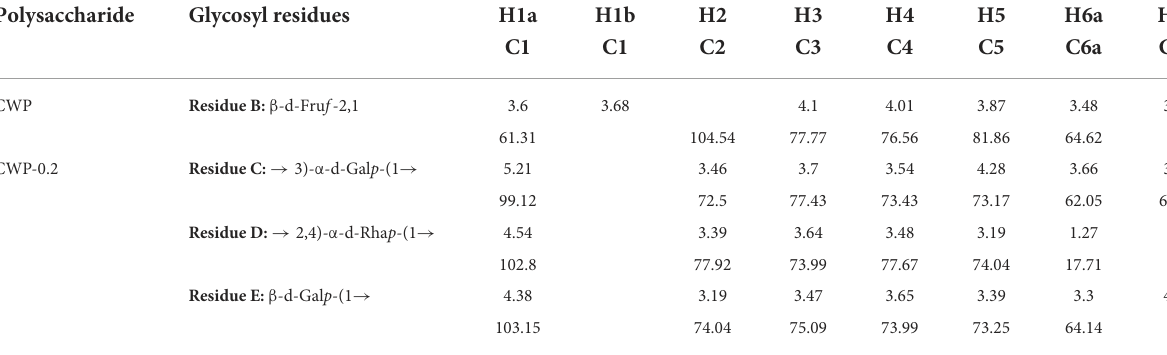
TABLE 3 The major 13 C NMR Chemical shift (ppm) for CWP and CWP-0.2. Polysaccharide